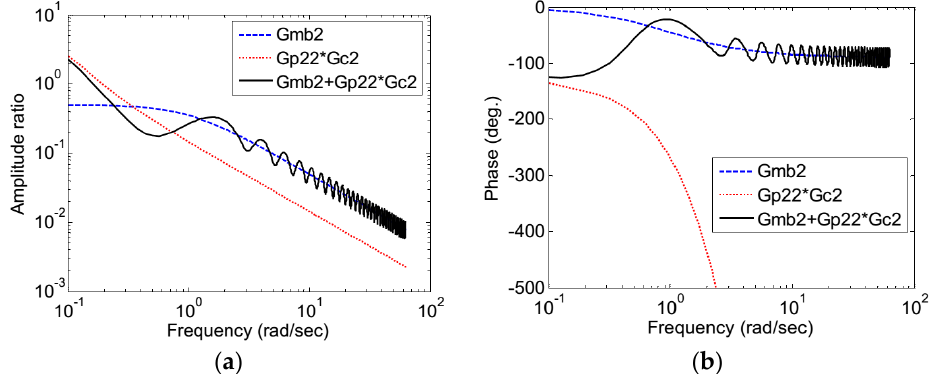
Figure 6. Frequency response of open-loop function for the second loop. ( a ) Amplitude Ratio ( b ) Phase.